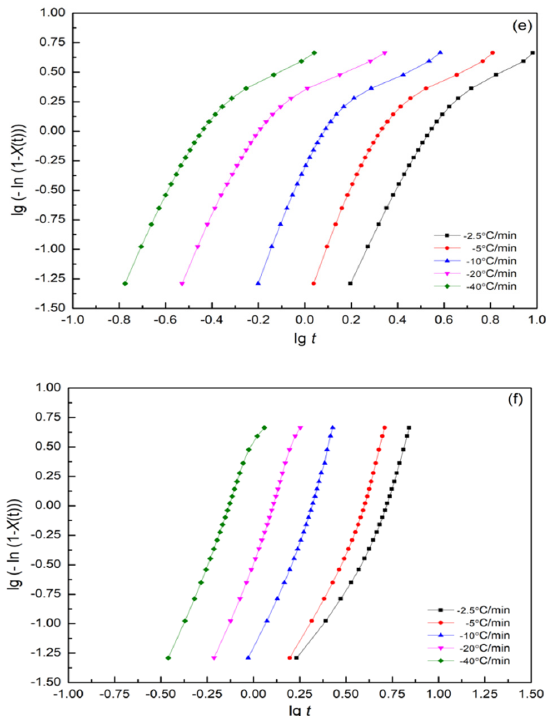
Figure 12. Plots of log {− ln [ 1 − x ( t )] } versus log t for the nonisothermal crystallization of ( a ) PA56, ( b ) CoPA ‐ 1, ( c ) CoPA ‐ 2, ( d ) CoPA ‐ 3, ( e ) CoPA ‐ 4 and ( f ) PA66. Table 6. The values of 𝑛 , 𝑍 (cid:3047) and 𝑍 (cid:3030) from the Avrami equation at the two stages of nonisothermal crystallization. Secondary Crystallization Primary Crystallization Stage Stage